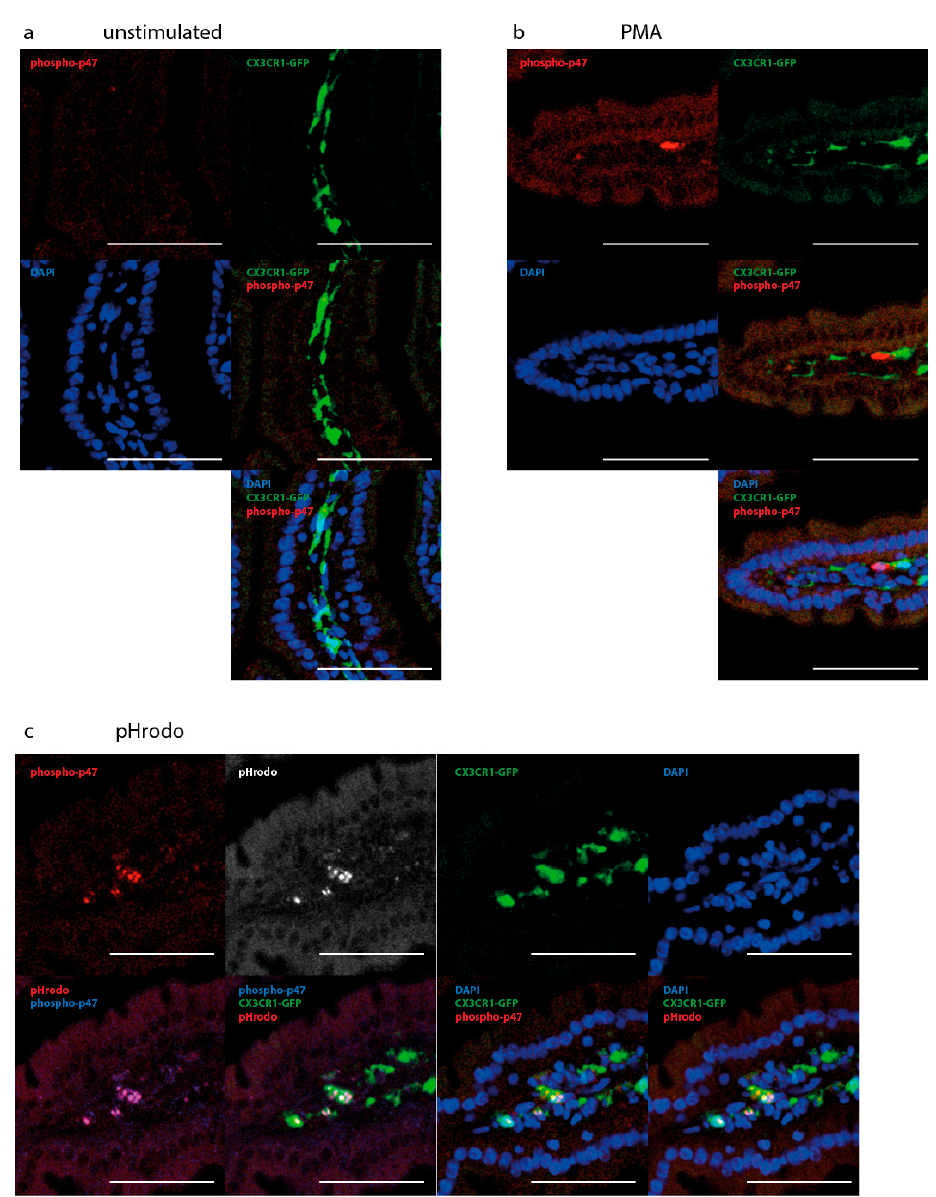
Figure 5. Induction of p47phox-phosphorylation by activating stimuli. ( a ) Immunofluorescence micrograph of the small intestine from a CX3CR1-GFP mouse, immunostained for phospho-p47. In the steady-state, minimal p47 phosphorylation is observed. ( b ) Immunofluorescence micrograph of the small intestine from a CX3CR1-GFP mouse, after incubation with PMA for 10 min, immunostained for phospho-p47. p47Phox is rapidly phosphorylated at Ser359 upon PMA stimulation in epithelial and LP cells. ( c ) Immunofluorescence micrograph of the small intestine from a CX3CR1-GFP mouse, after application of pHrodo bioparticles for 30 min, pHrodo particles colocalize with phospho-p47, and phospho-p47 is largely restricted to pHrodo + GFP + cells. Epithelial cells exhibit a low level of p47 phosphorylation after incubation with pHrodo particles, but the increase is not as marked as with PMA stimulation. Immunofluorescence images are representative of two independent experiments, Scale bar: 50 µm.